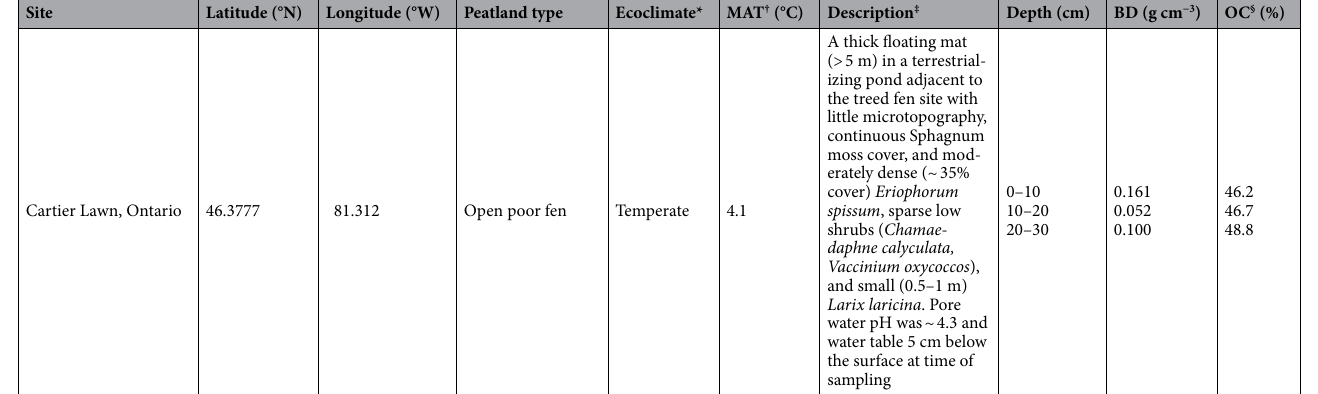
Table 1. Peatland sampling site information. Peat samples collected from each of the 10-cm depth intervals were analyzed for dry bulk density (BD, g cm −3 ) and organic carbon content (OC, %). *According to